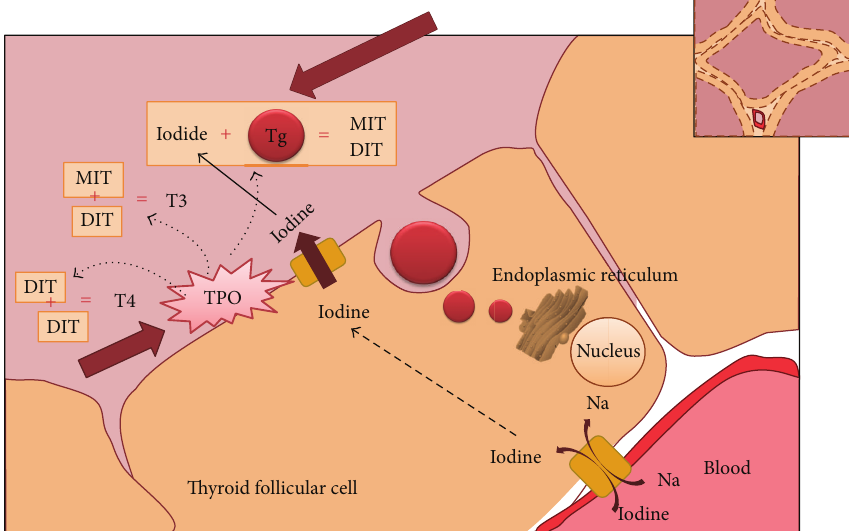
Figure 1: Thyroglobulin and thyroid peroxidase in thyroid hormone biosynthesis. The essentiality of thyroglobulin and thyroid peroxidase is shown in this simplified diagram of thyroid hormone biosynthesis. Thyroglobulin acts as the skeleton in thyroid hormone synthesis. It is synthesized and glycosylated in the rough endoplasmic reticulum, and is exocytosed through the apical membrane. Thyroid peroxidase acts in three parts (a) it oxidizes iodine, (b) organifies iodide to the tyrosine residues to the thyroglobulin forming monoiodotyrosine and di- iodotyrosine (c) Couples monoiodotyrosine and di-iodotyrosine to either T4 or T3 (TPO: thyroid peroxidase, Tg: thyroglobulin, MIT: monoiodotyrosine, DIT: di-iodotyrosine, T4: thyroxine, and T3: triiodothyronine).